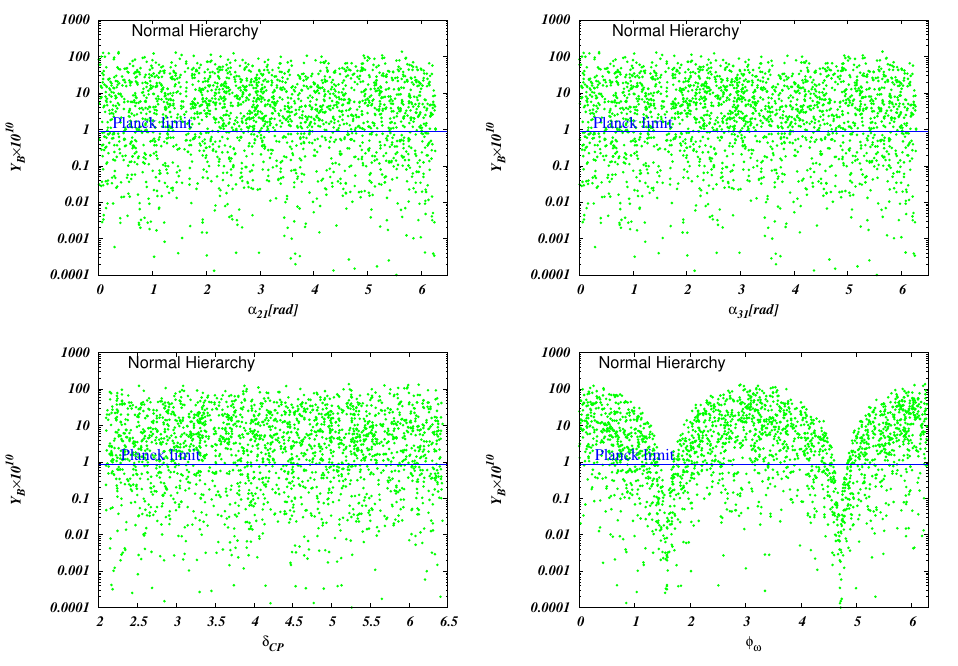
Figure 6 . The baryon asymmetry Y B as a function of Majorana phases α 21 (top left), α 31 (top right), Dirac CP phase δ (bottom left) and the high energy CP phase φ CP horizontal blue line corresponds to the Planck